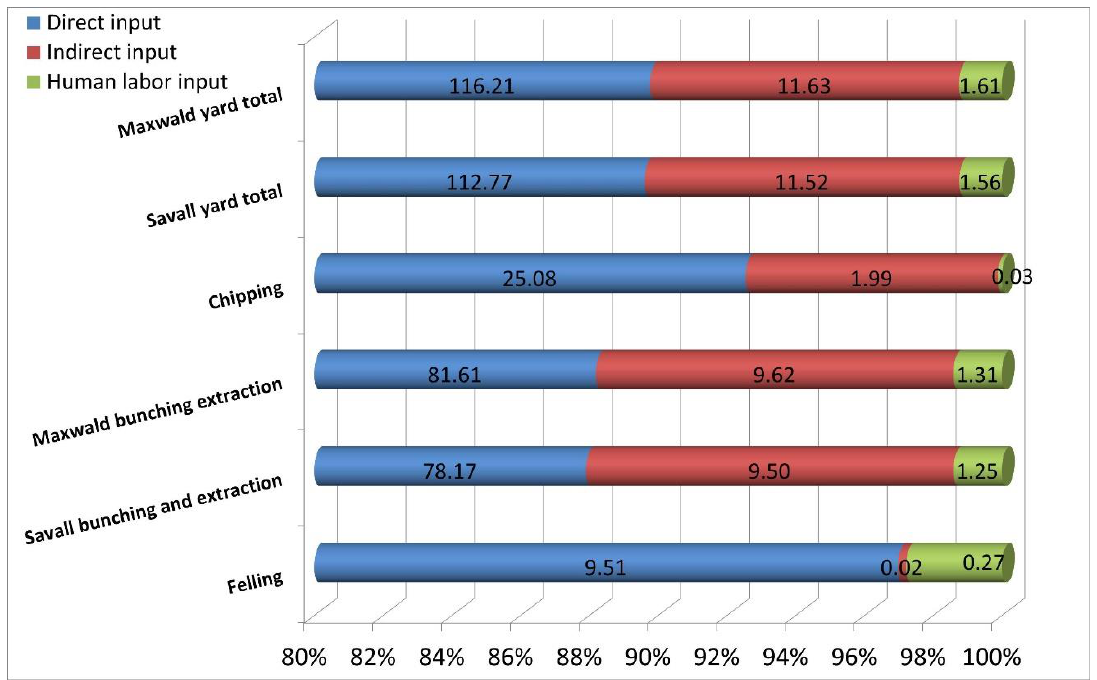
Figure 3. Energy inputs categories in forestry logging operations, data reported in percentage referred to the total inputs and detailed data are reported in MJ/m 3 for every category and showed in the figure.